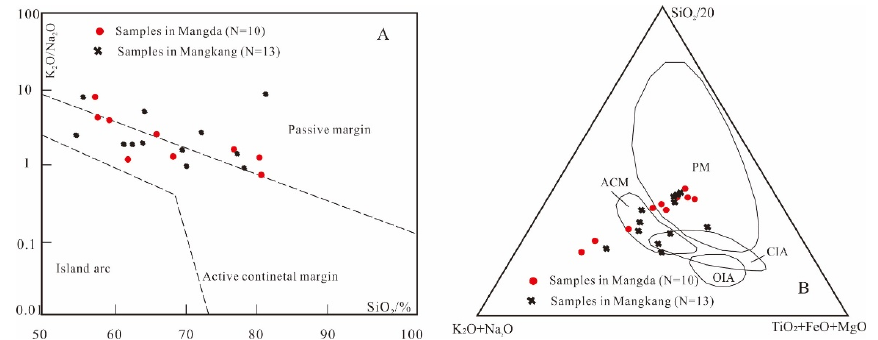
Figure 10. Tectonic setting discrimination diagrams based on the major elements for Jingxing Formation sandstones of Qamdo district ( A after Bhatia and Crook [71], and B after Kroonenberg [72]). Abbreviations: OIA, ocean island arc; CIA, continental island arc; ACM, active continental margin; PM, passive margin.